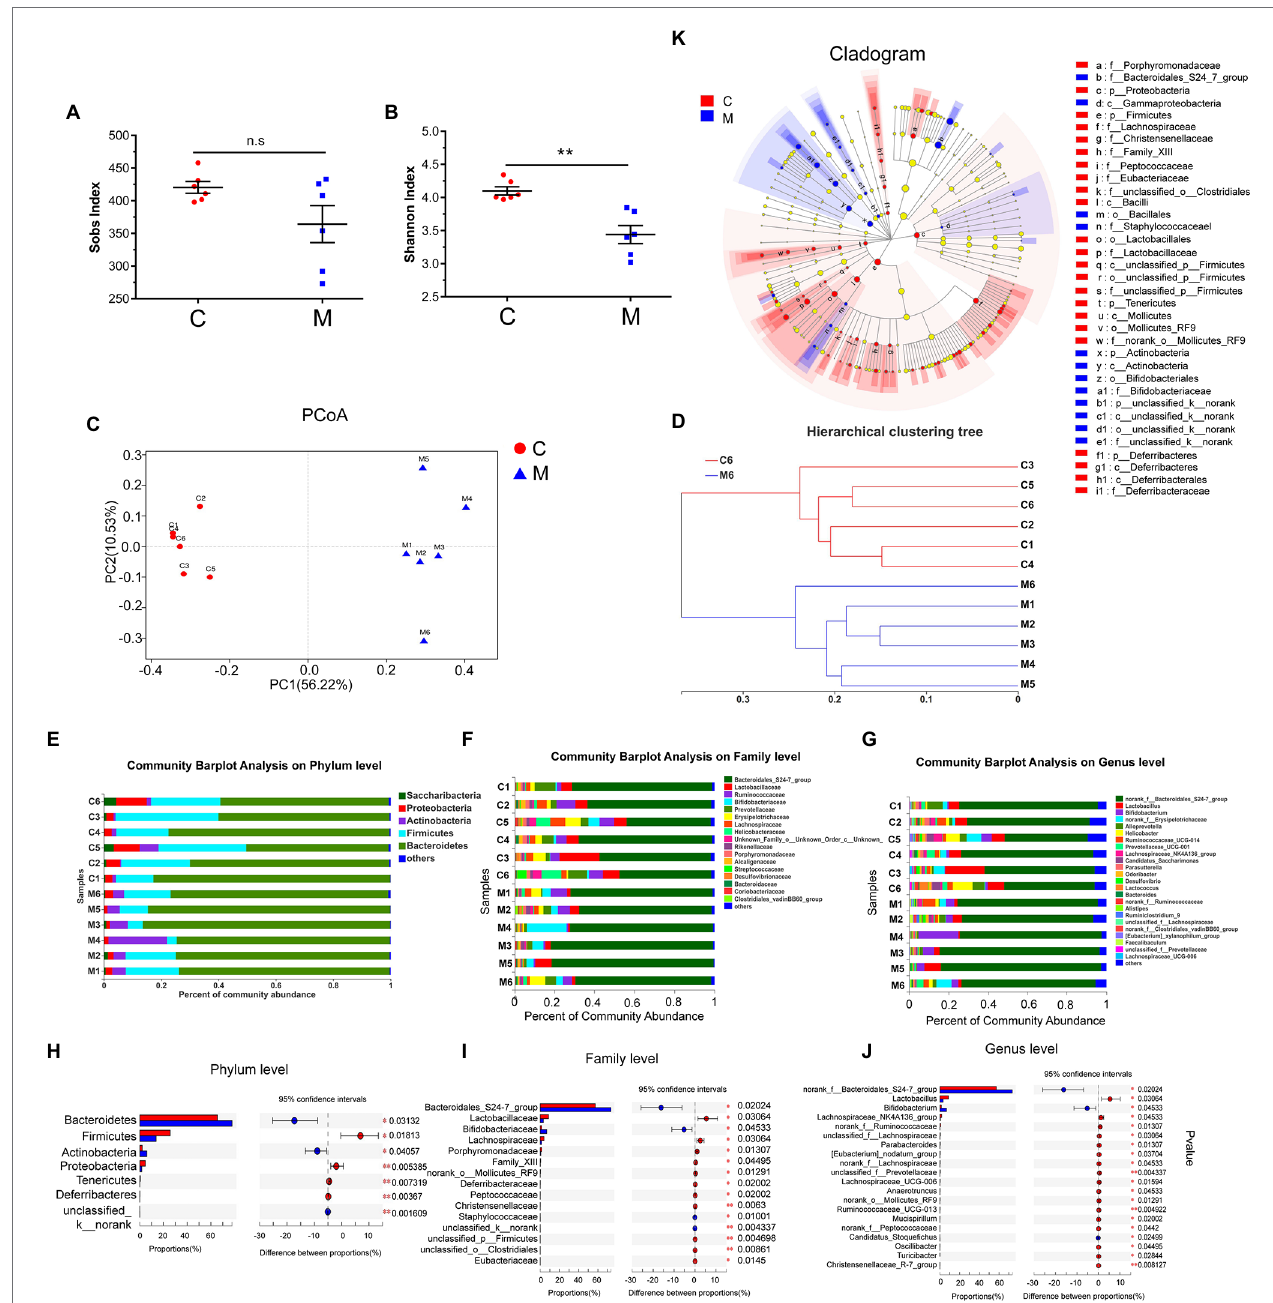
FIGURE 2 | Methamphetamine induced the disturbance of gut microbiome in mice. Sobs (A) and Shannon indices (B) reflect the alterations of microbial diversity and richness between the control and MA groups. Microbial structures of MA (blue) and control samples (red) were assessed by Principal co-ordinate analysis (PCoA; C ) and Hierarchical clustering tree (D) using Unweighted Pair-group Method with Arithmetic Mean (UPGMA). Community Barplot analysis showed the microbial composition and relative abundance of all samples on Phylum, Family, and Genus level (E–G) , while the differential microbiota at each taxon between two groups was screened using Wilcoxon rank-sum test referring to Mann–Whitney U tests (CI was set at 95%; H–J ). LEfSe Cladogram further showed the differential microbiota at different taxon (K) , 0.01 < * p < 0.05; 0.001 < ** p ≤